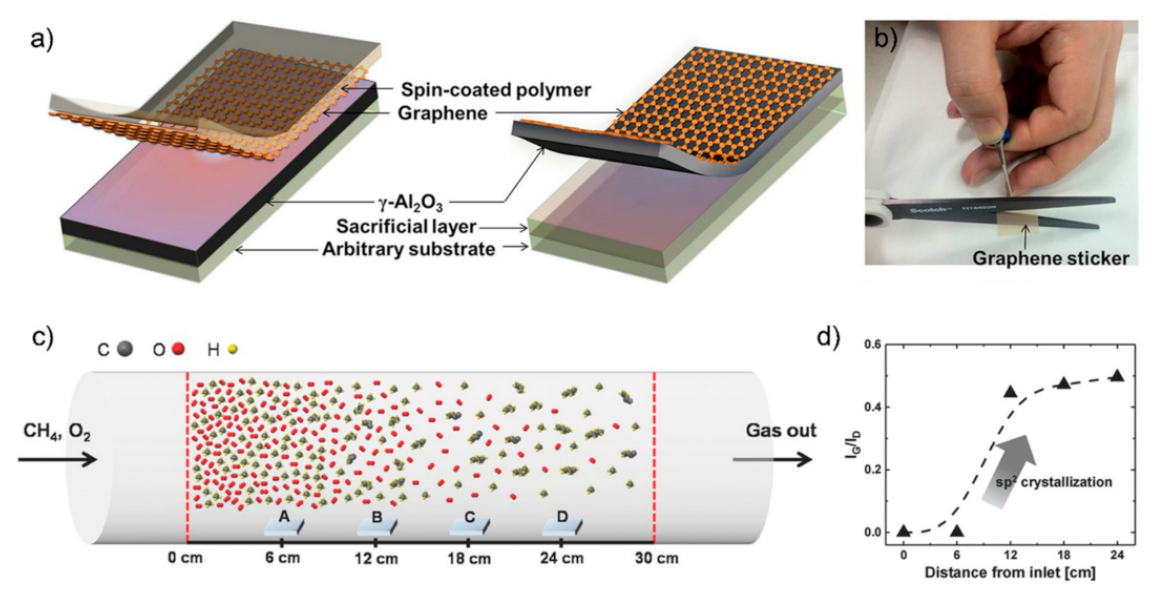
Figure 4. ( a ) Graphical representations of preparing readily detachable graphene sticker; ( b ) Photograph of processing of graphene sticker; ( c ) Molecular dynamics during adsorption process on Al(III) sites; ( d ) Distance dependent Raman intensity ratio indicating change in sp 2 formation; ( a , b ) Reproduced with permission from [95]. Copyright Scientific Reports, 2015. ( c , d ) Reproduced with permission from [101]. Copyright WILEY-VCH Verlag GmbH & Co. KGaA, Weinheim,